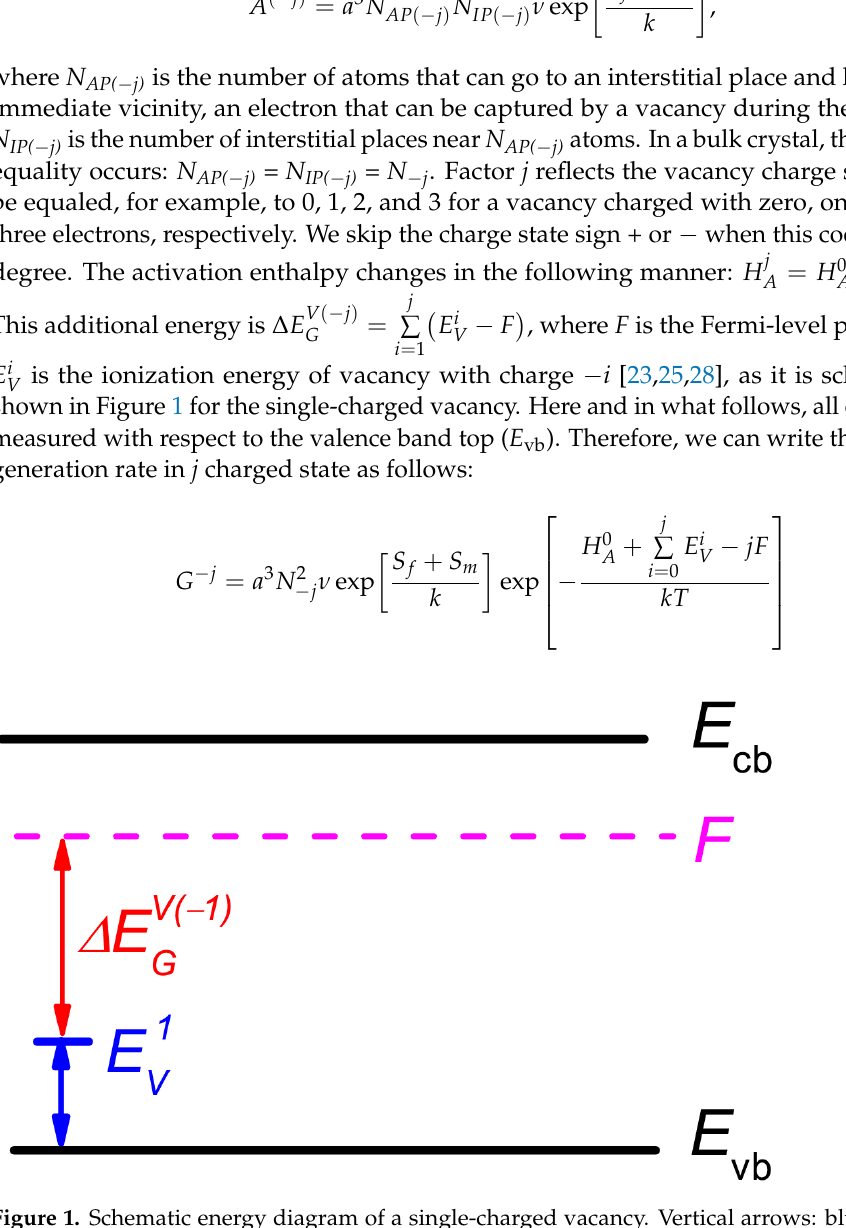
Figure 1. Schematic energy diagram of a single-charged vacancy. Vertical arrows: blue—charged vacancy ionization energy; red—energy gap between vacancy ionization energy and Fermi level (dashed magenta).